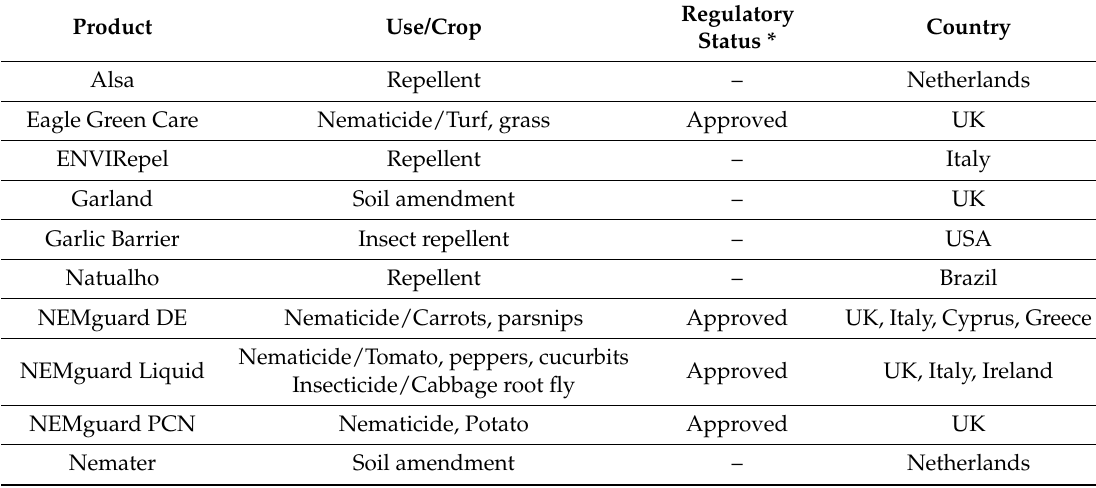
Table 4. Various garlic-based products on the